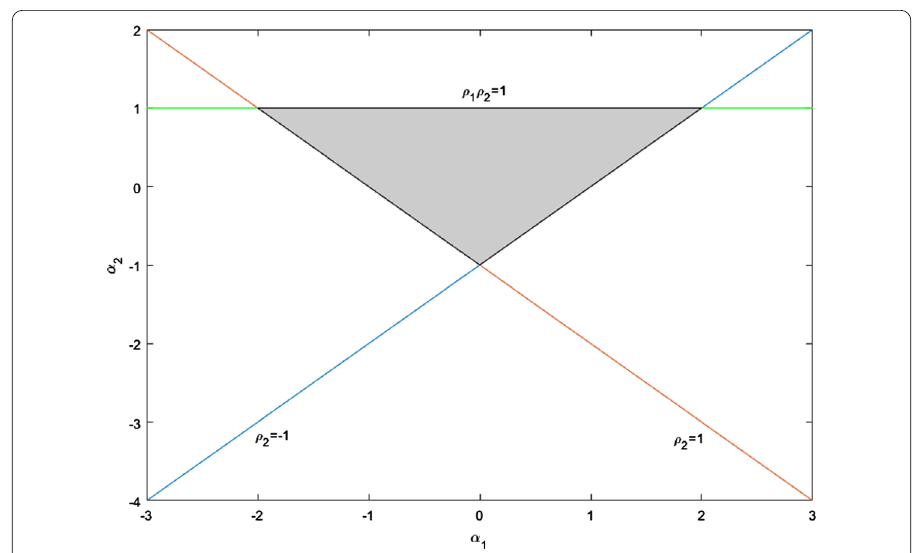
Figure 6 The stability region of controlled system (4.6) in the ( α 1 , α 2 ) plane